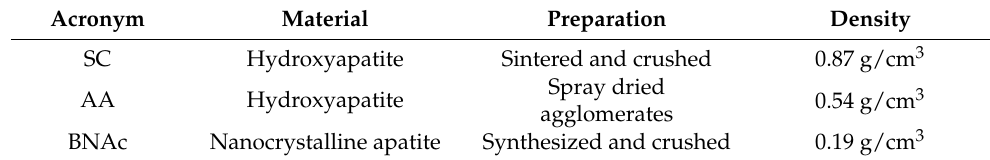
Table 2. Powders used for cold spray coatings, acronyms and main properties.